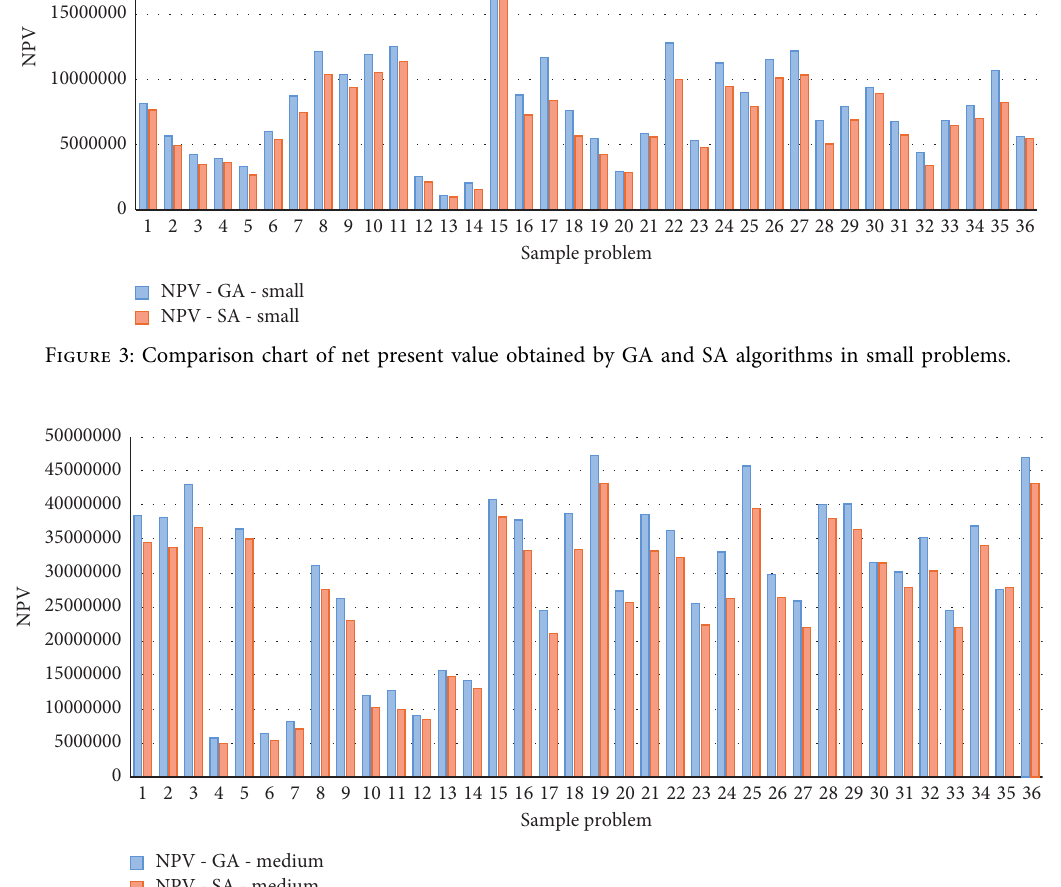
Figure 4: Comparison chart of net present value obtained by GA and SA algorithms in medium problems.